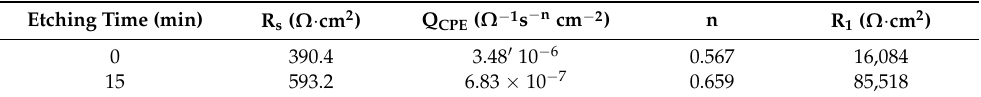
Table 3. Impedance parameters obtained by fitting the impedance spectrum.